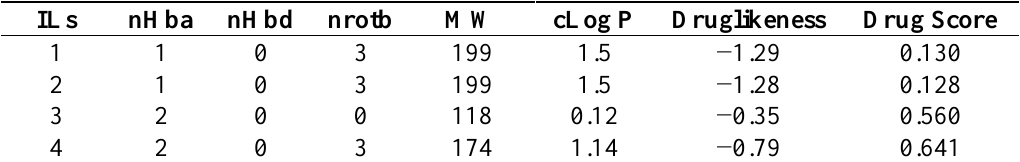
Table 1. Pharmacokinetic parameters (Catalyst, Chemaxon and Osiris